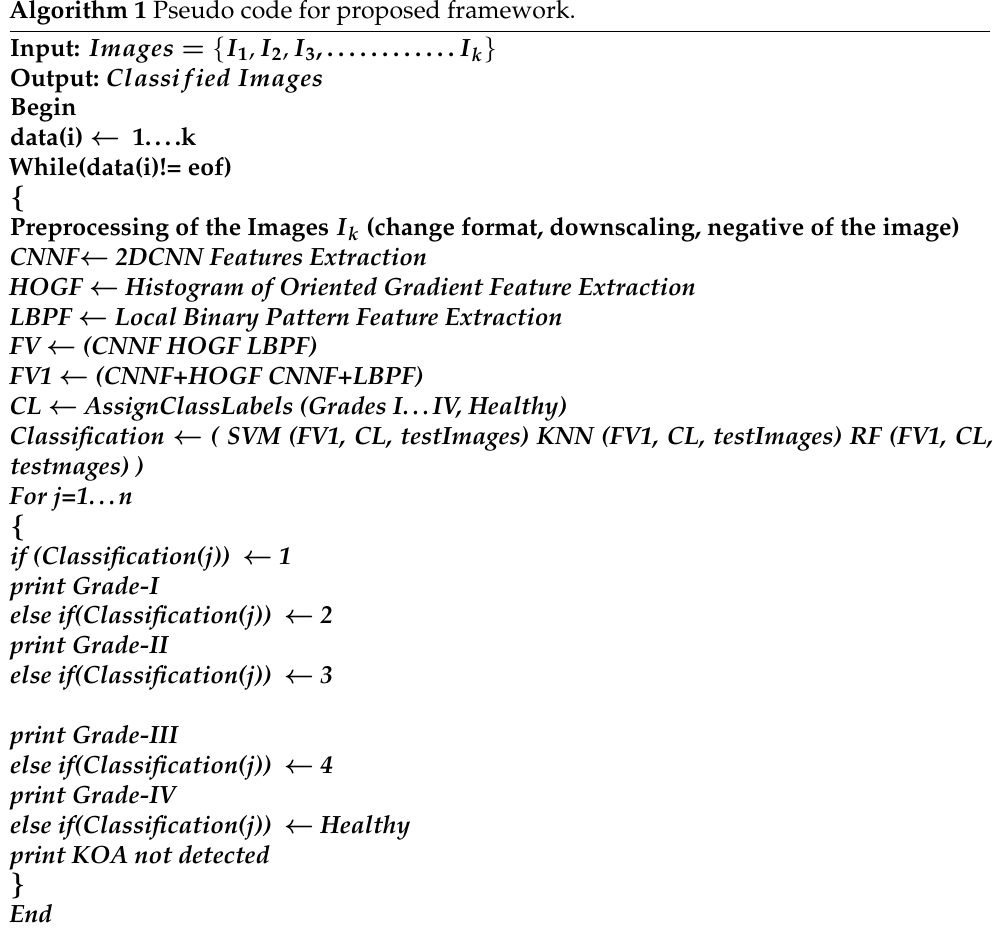
Algorithm 1 Pseudo code for proposed